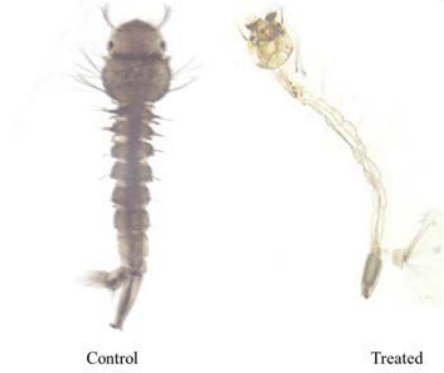
Fig. 5. Mortality of silver nanoparticles synthesized from Caryota urens different concentration with different